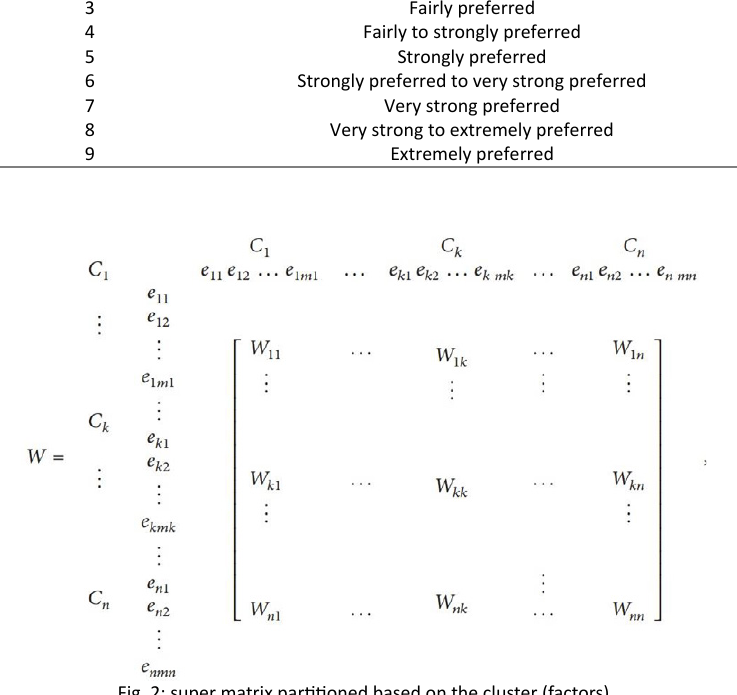
Fig. 2: super matrix partitioned based on the cluster Fig.2: super matrix partitioned based on the cluster (factors)